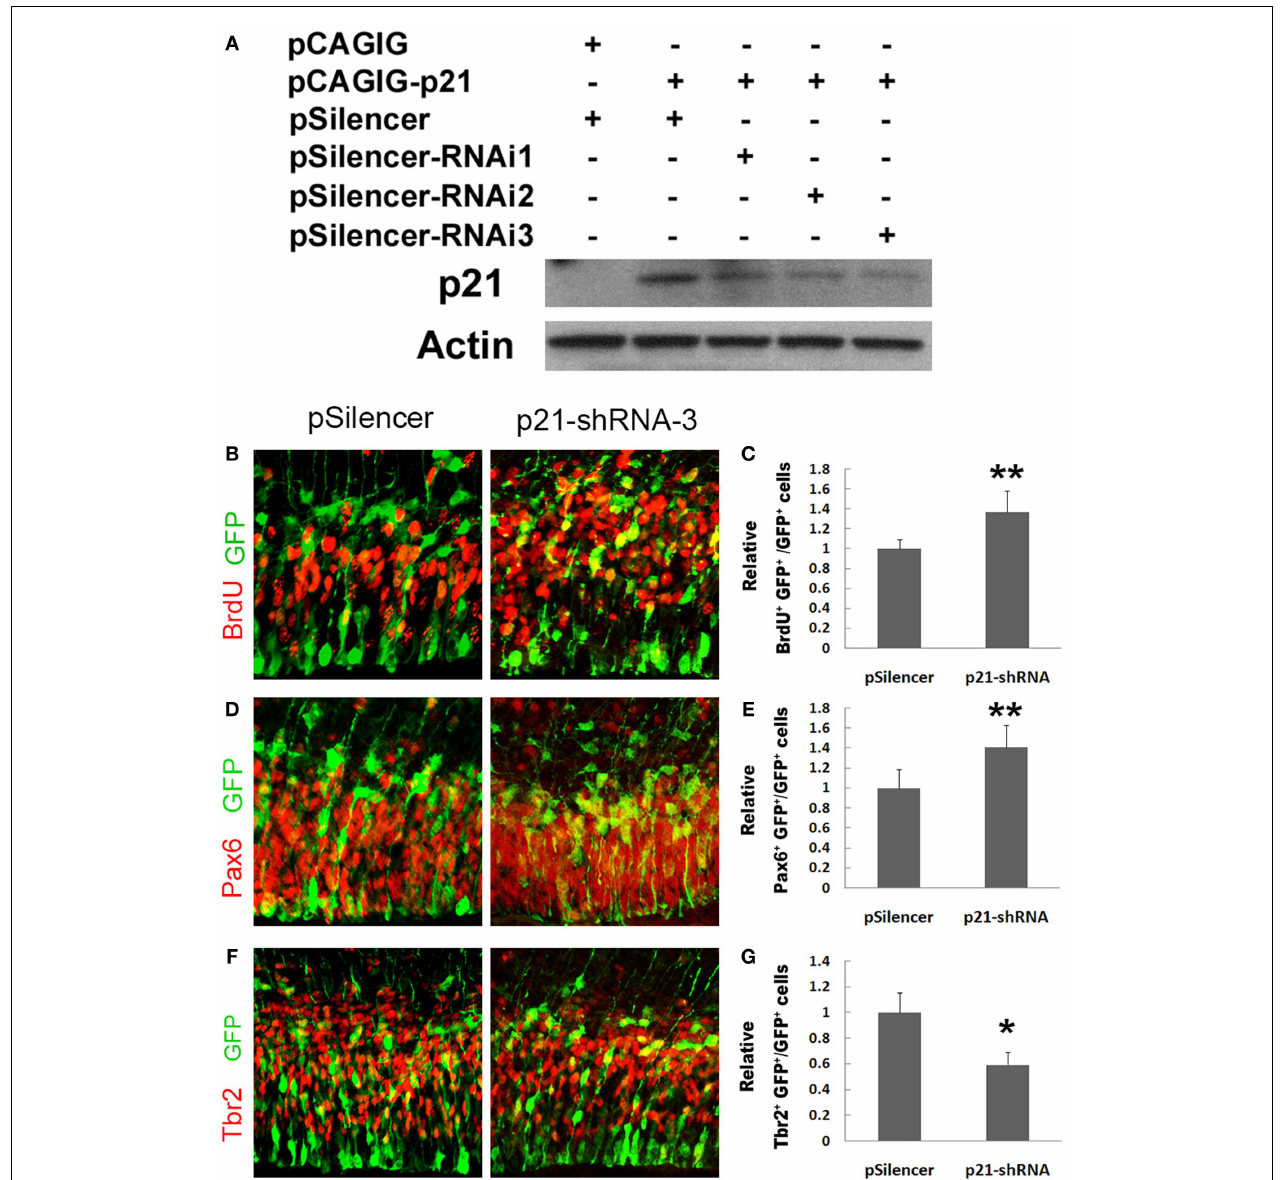
the empty vector pSilencer ( n = 3). (D,E) Blocking the p21 expression ( n = 5) using the p21–shRNA increased the number of RGCs co-labeled with GFP and Pax6. (F,G) Blocking the p21 expression ( n = 6) using the p21–shRNA decreased the number of IPs co-labeled with GFP andTbr2. Data are presented as mean ± SEM; n ≥ 3 in all constructs; p values in relation to the control (* p < 0.05, ** p <